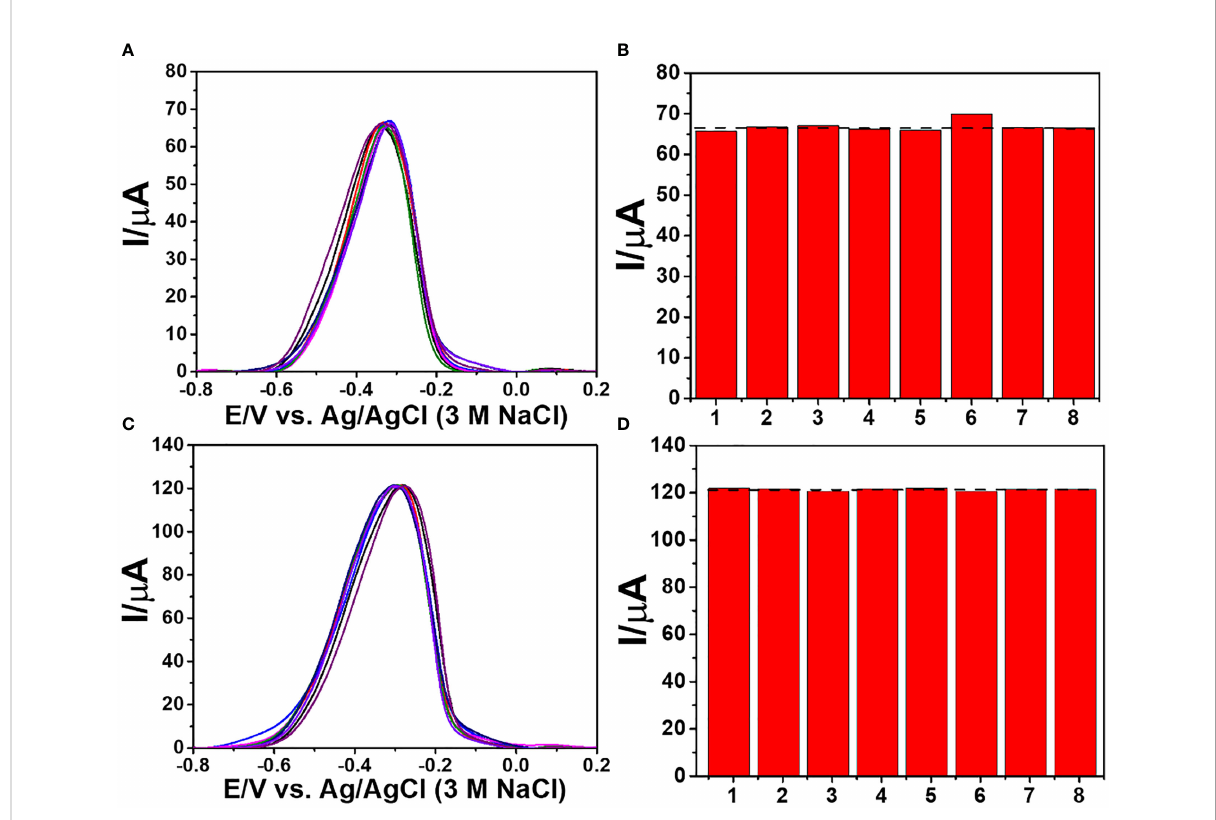
FIGURE 8 Reproducibility study of the immunosensor for the detection of 0.10 and 50.0 ng ml -1 AFP; (A, C) DPV sensorgrams and (B, D) corresponding current